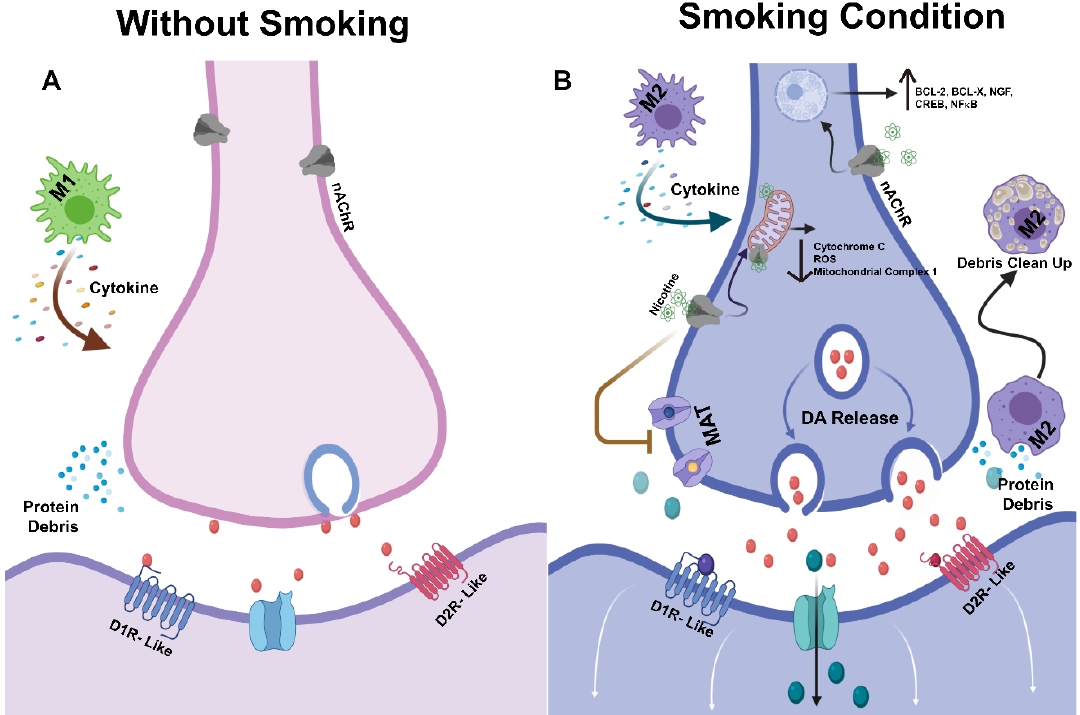
Figure 7. General mechanism of nicotine-induced neuronal protection. ( A ) Under degenerative inflammatory conditions, resident M0 macrophages polarize into M1 macrophages or pro-inflammatory macrophages, which release inflammatory cytokines. Cellular debris also deteriorates the cellular conditions of DAergic neurons. ( B ) Nicotine provides protection to injured DAergic neurons. Cellular protection can occur either via improvement of the neuronal microenvironment or by direct effects on DAergic neurons. Nicotine either converts resident M0 macrophages into M2 anti-inflammatory macrophages or it upregulates anti-apoptotic genes by acting on nAChRs. Figures created with biorender.com/ (accessed on 21 February 2021).